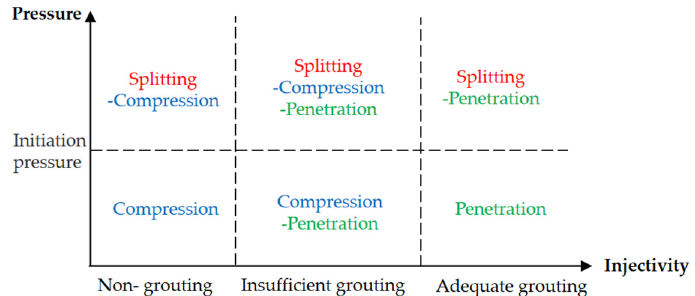
Figure 16. Division of slurry diffusion mode.